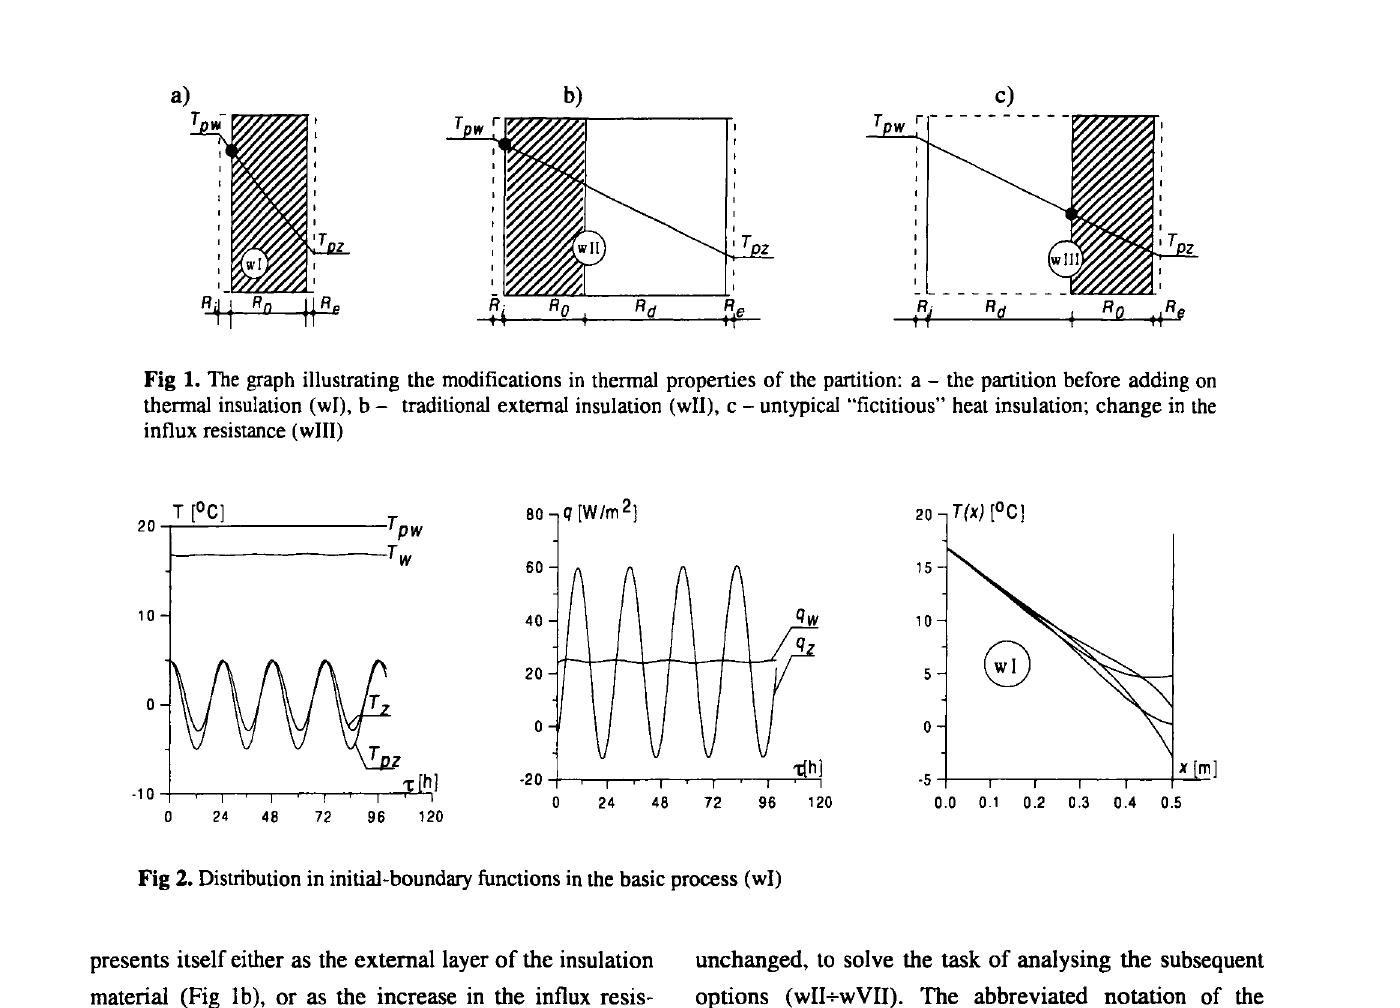
presents itself either as the external layer of the insulation material (Fig 1 b), or as the increase in the influx resis tance (Fig